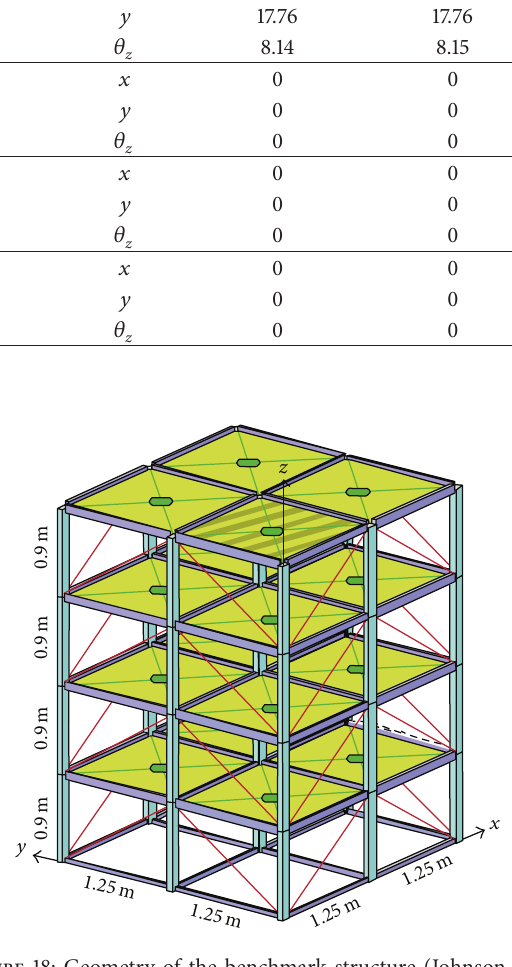
Figure 18: Geometry of the benchmark structure (Johnson et al. 2004